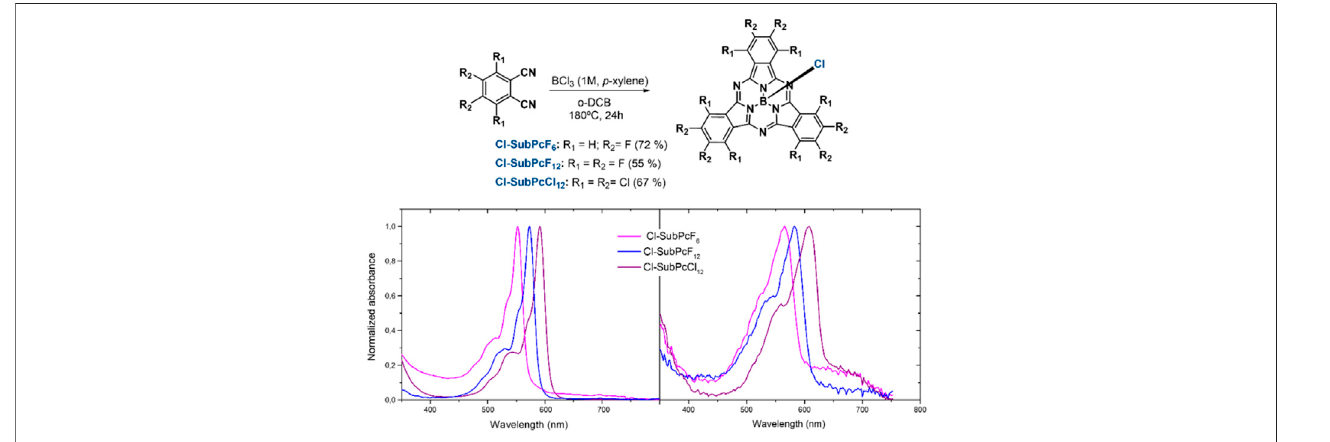
FIGURE 1 | Synthetic route and UV/Vis absorbance spectra in solution (THF) (right) and in a thin fi lm (left) of Cl-SubPcF 6 , Cl-SubPcF 12, and Cl-SubPcCl 12 .